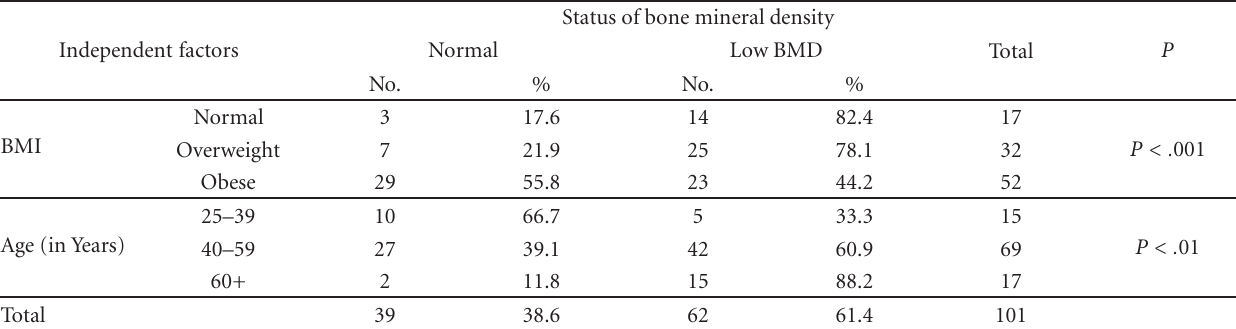
Table 3: Association between bone mineral density and independent factors.